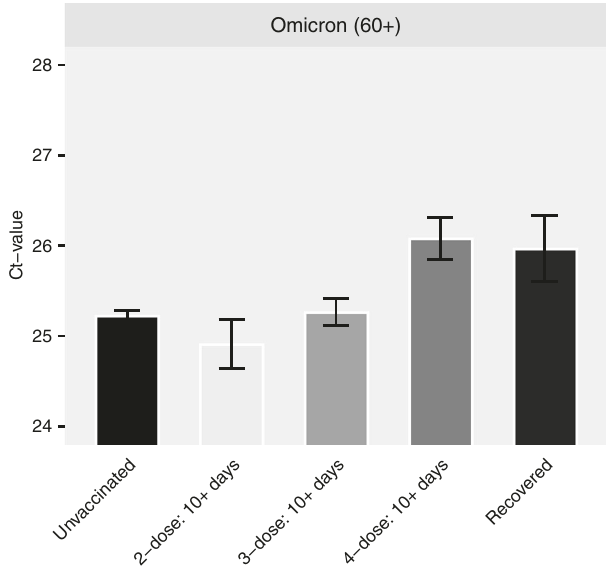
Fig. 2 | Ct values of the gene N for older adults during Omicron ( n =25,925 independentsamples). AdjustedCtvaluesofdifferentvaccinationstatusesforthe Omicronvariantinindividualsofage>60.Meanswereobtainedfromtheweighted sum of age, sex and calendar time, and the reference group (see Supplementary Table 2). Error bars represent 95% CI ’ s around the means, obtained by using the estimated distribution of all labs together (see Methods).